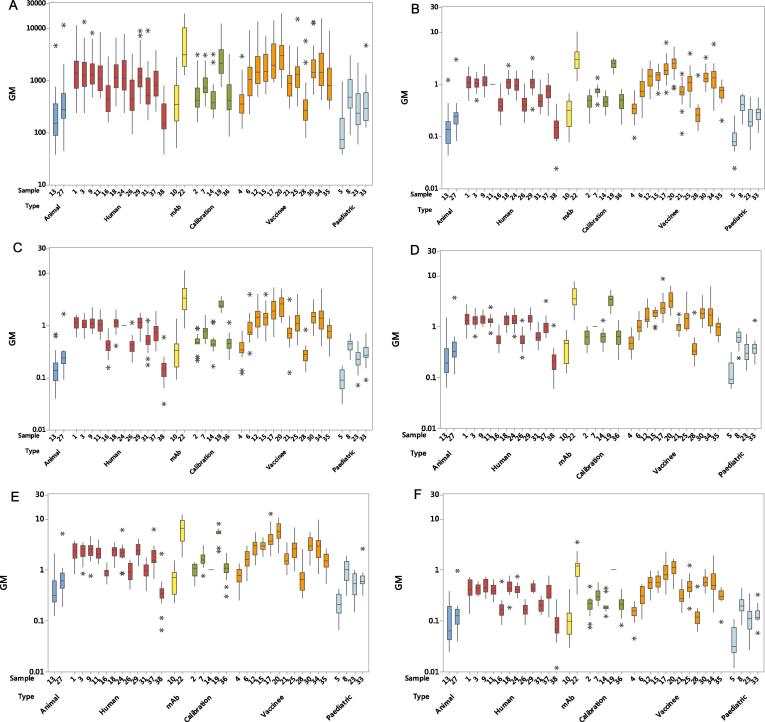
Inter-laboratory variability in ED50s and estimates of relative potencies. Laboratory geometric mean ED50s (A), potencies relative to 16/284 (B), potencies relative to 16/322 (C), potencies relative to sample 7 (D), potencies relative to sample 14 (E) and potencies relative to sample 19 (F). Sample groupings are represented as different colour boxes (dark blue = animal; red = human; yellow = monoclonal antibodies; green = BEI samples for calibration; orange = vaccine; pale blue = paediatric). *indicates outliers.